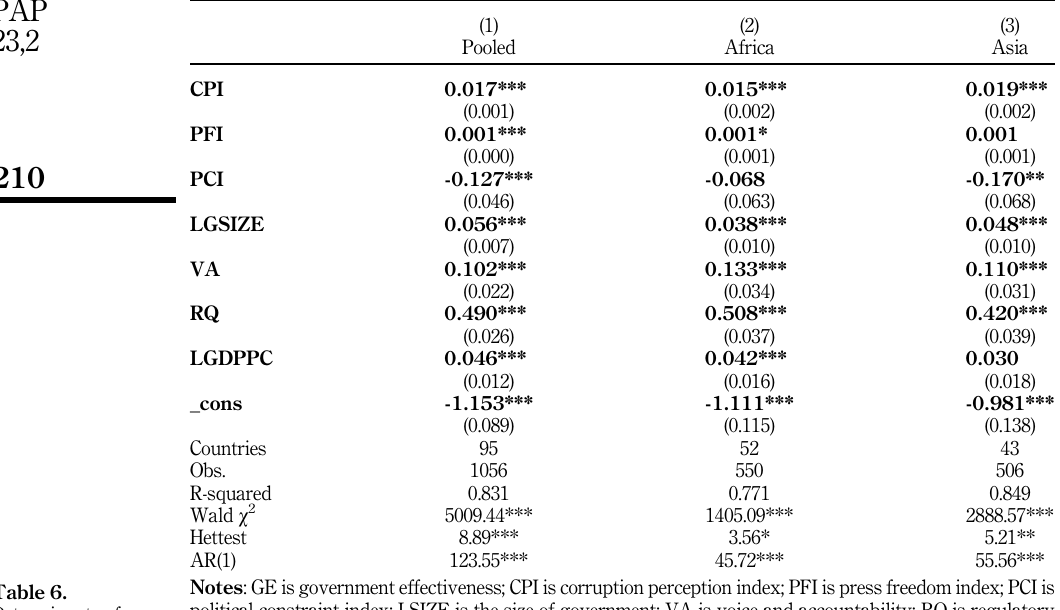
Table 6. Determinants of government effectiveness in Africa and